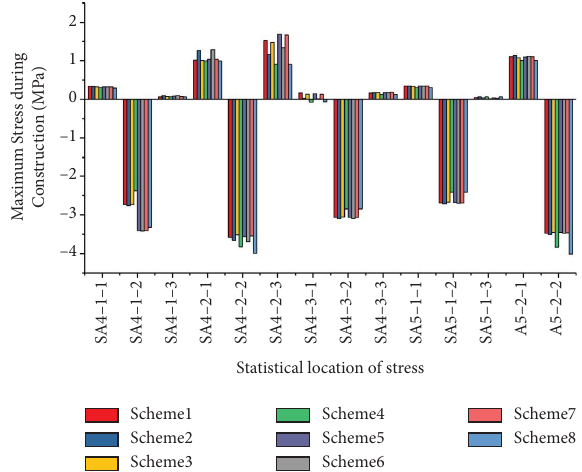
Figure 10: Comparative analysis of maximum stress of the beam element in the closure process of diferent closure